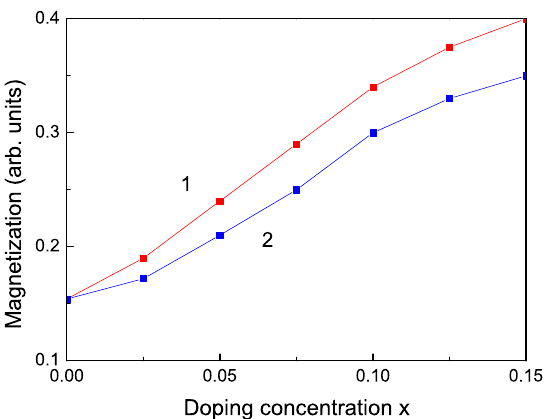
Figure 5. Doping concentration dependence of the spontaneous magnetization M s of a ZnS NP for N = 10 shells, T = 300 K for different doping RE ions: (1) Dy; (2)